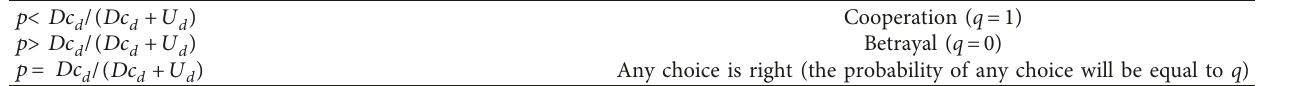
Table 2: Optimal response strategy of the capital provider.